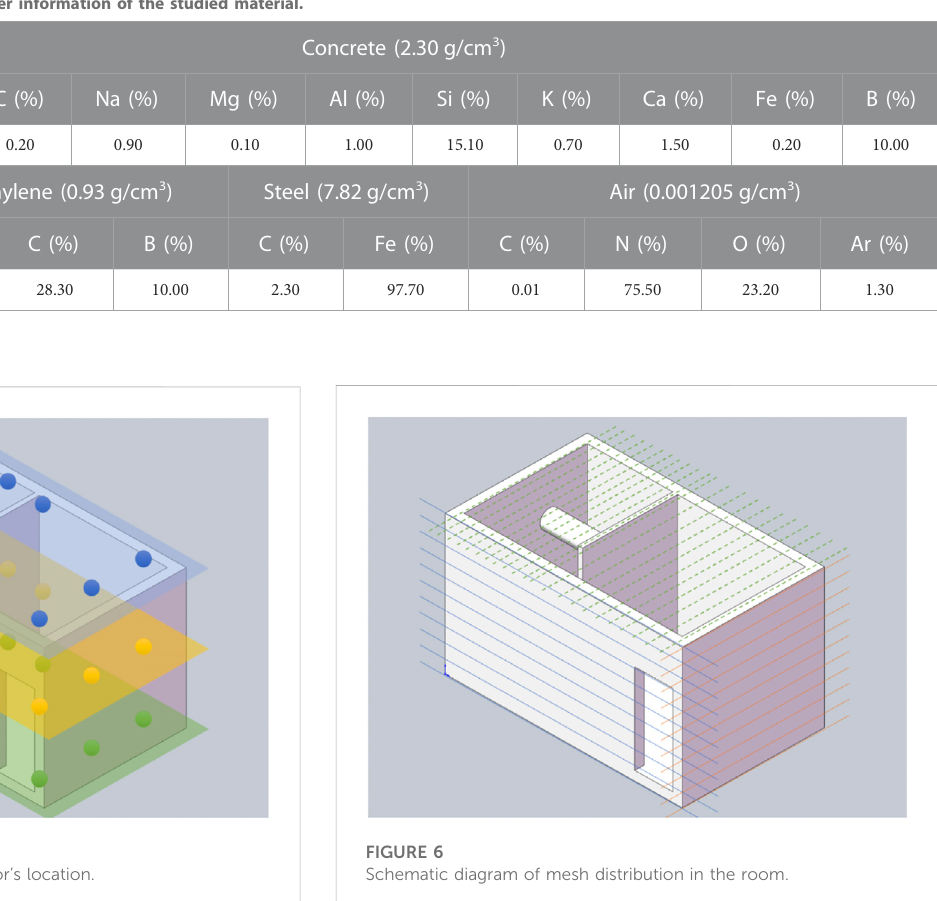
TABLE 1 Nuclide and density parameter information of the studied material.